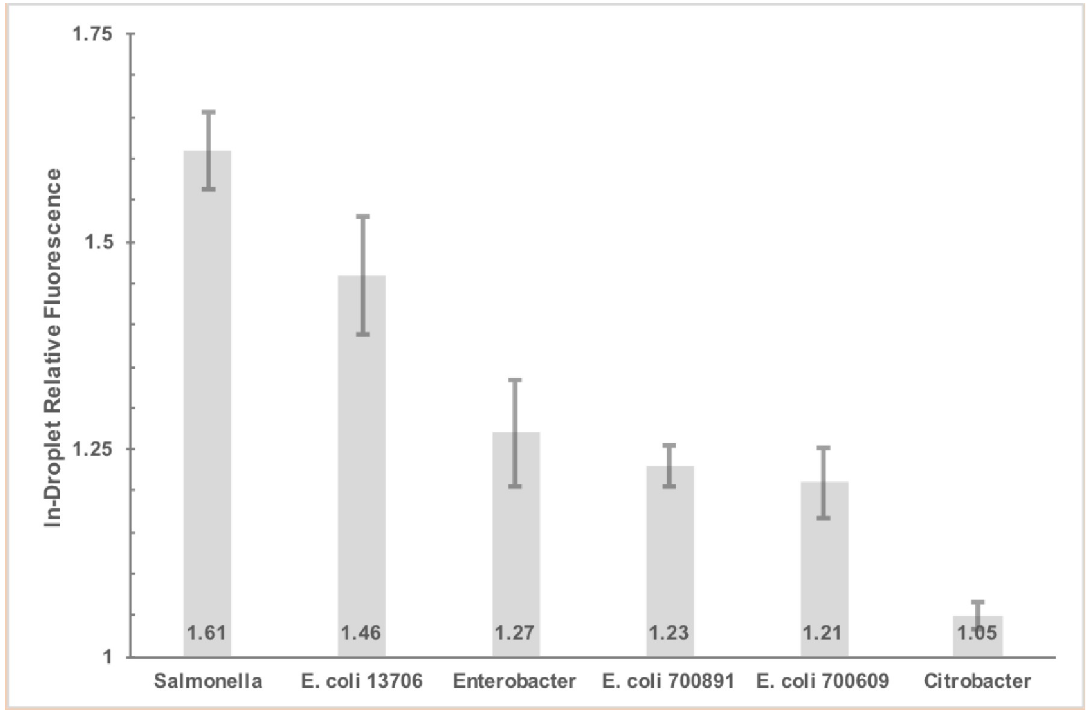
Fig 3. Fluorescence of bacteria relative to background fluorescence in-droplet of six bacterial species encapsulated in droplet with 0.83 μ g/ml FITC-Ab per droplet in phosphate buffered saline. Five fluorescence measurement replicates were performed per bacterial species/strain. Error bars represent the 95% confidence